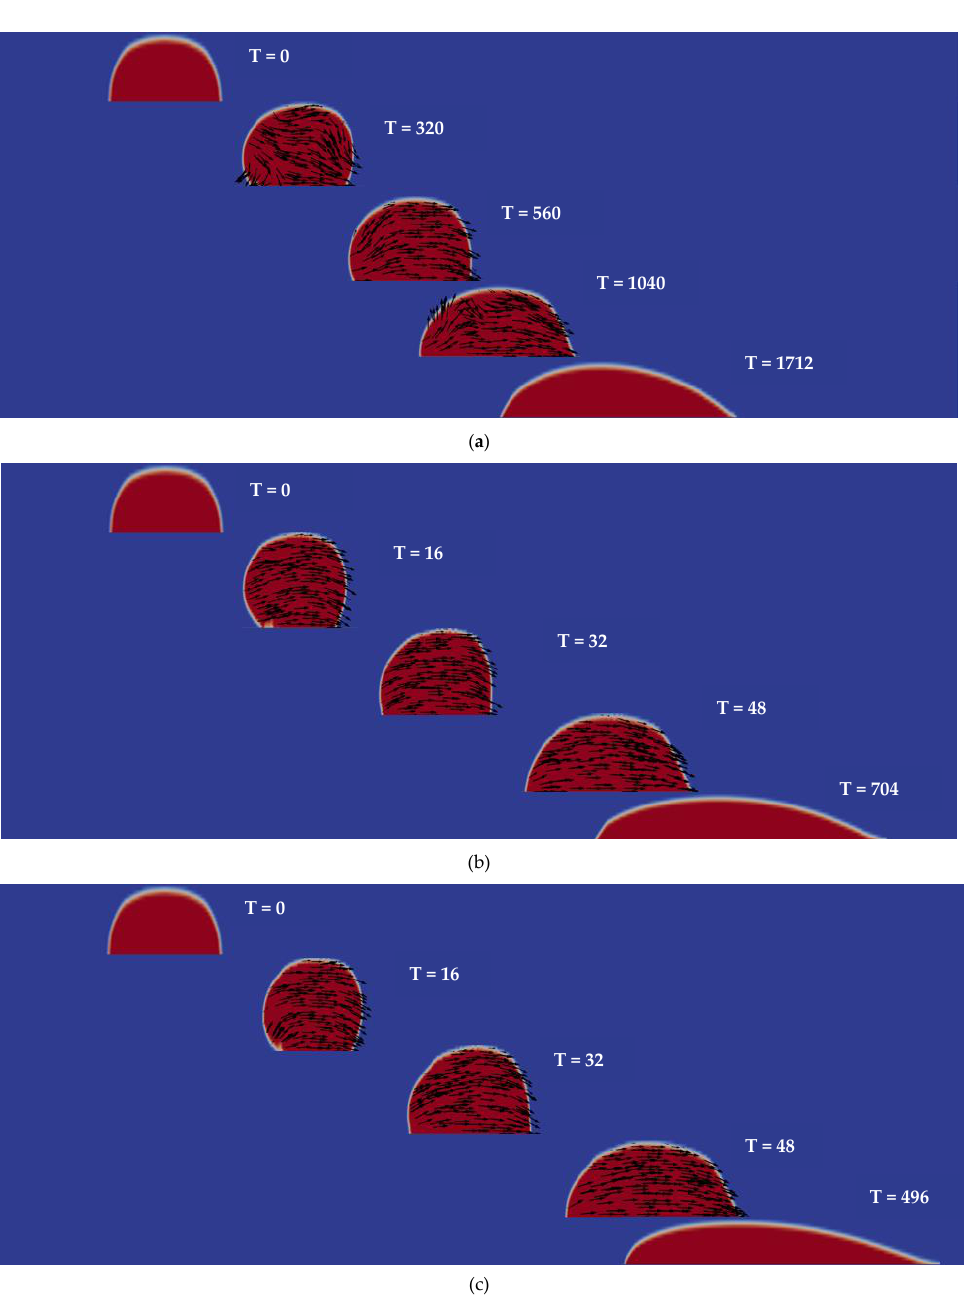
Figure 2. ( a ) Migration of a Newtonian droplet ( b ) Migration a of viscoelastic droplet with Wi = 16 ( c ) with Wi =